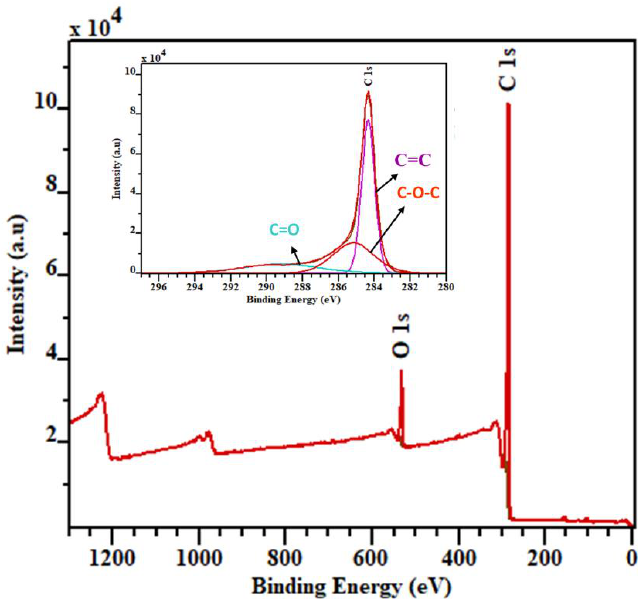
Figure 2. X-ray photoelectron spectra of coconut shell biochar.